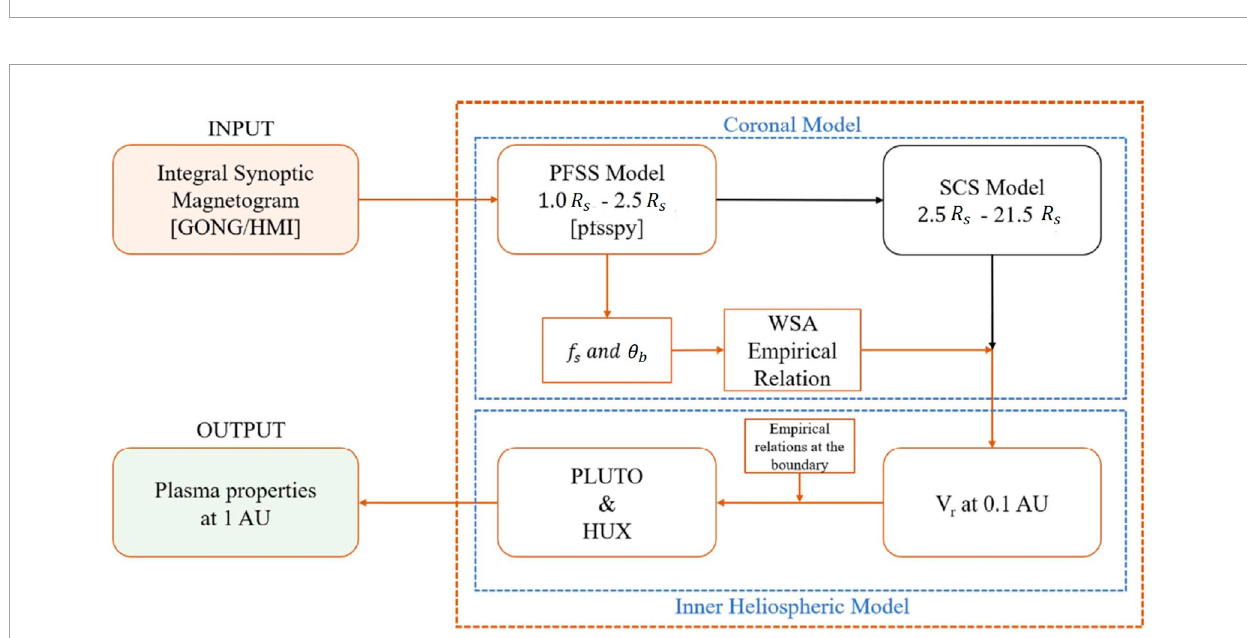
FIGURE 6 Flowchart of the models utilized in the work (Kumar et al., 2020).